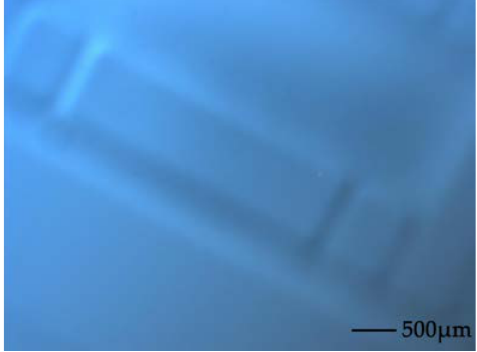
Figure 3. Photograph of the underlying structures that appeared during CMP.